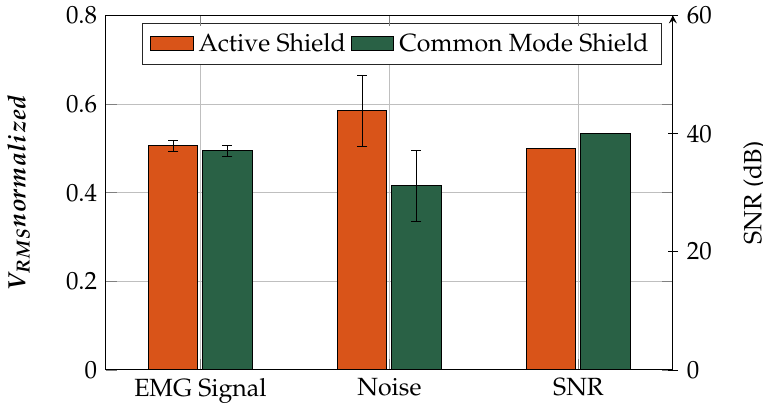
Figure 19. Normalized V RMS of EMG signal, and noise for active and common-mode shielding. Note that the V RMS values are normalized, so the sum of the mean V RMS at each comparison results to 1. The absolute EMG V RMS are considerably higher than the noise V RMS values. SNRs of the absolute mean EMG V RMS and the absolute mean noise V RMS are